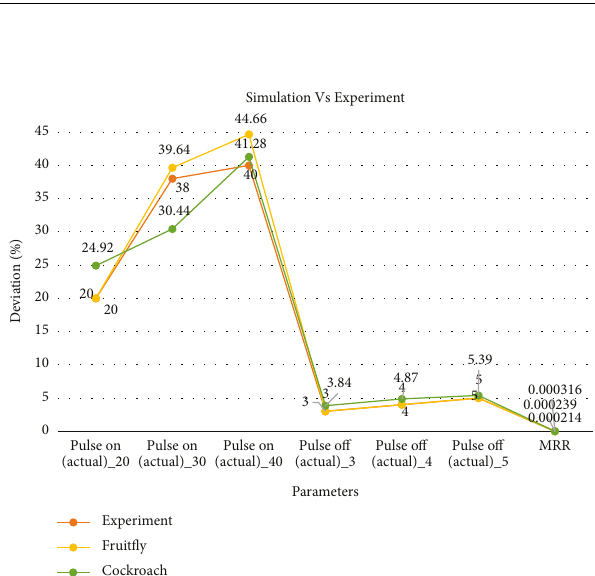
Figure 13: Deviation in MRR and its respective parameter values of aluminium predicted by fruit fly and cockroach algorithm with laboratory experiment.